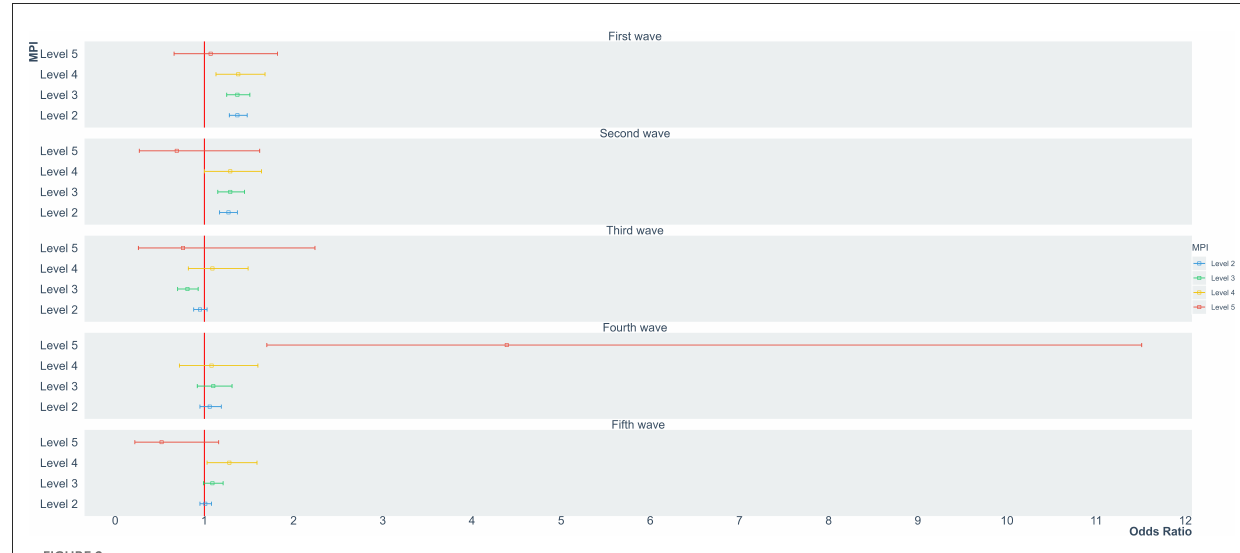
FIGURE2 Odds ratio of death according to CMPI levels in patients hospitalized for COVID-19 in Colombia, by COVID-19 waves: First wave: May 1, 2020 to September 9, 2020; Second wave: September 10, 2020 to November 15, 2020; Third wave: November 16, 2020 to February 19, 2021; Fourth wave: February 20, 2021 to May 1, 2021; Fifth wave: May 2, 2021 to August 15,